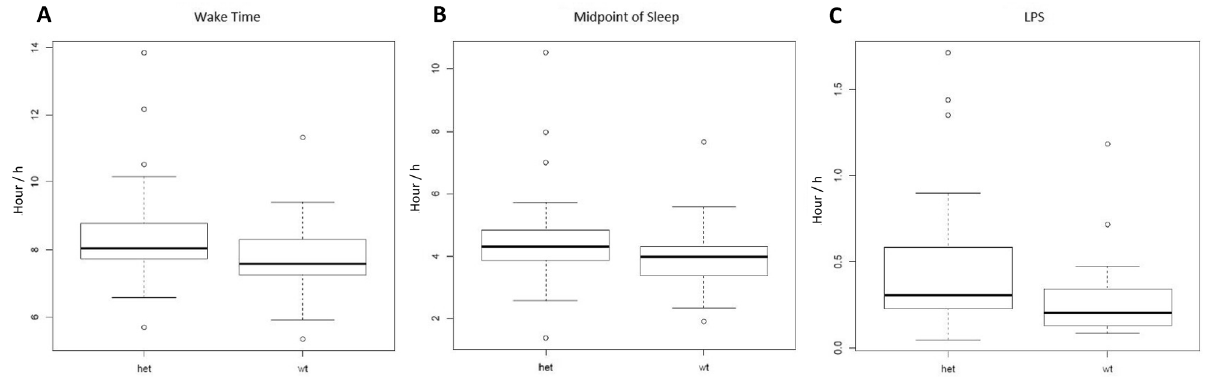
Figure 2. Boxplots showing significant differences in sleep parameters based on data collected over a period of 28 days (electronic daily diary) for CRY1Δ11 variant group (n = 33) compared to WT controls (n = 34). A. Wake Time p wilcoxon = 0.02 (y-axis is time in hours). B. Midpoint p wilcoxon = 0.03 (y-axis is time in hours). C. LPS p wilcoxon = 0.001 (y-axis is time in